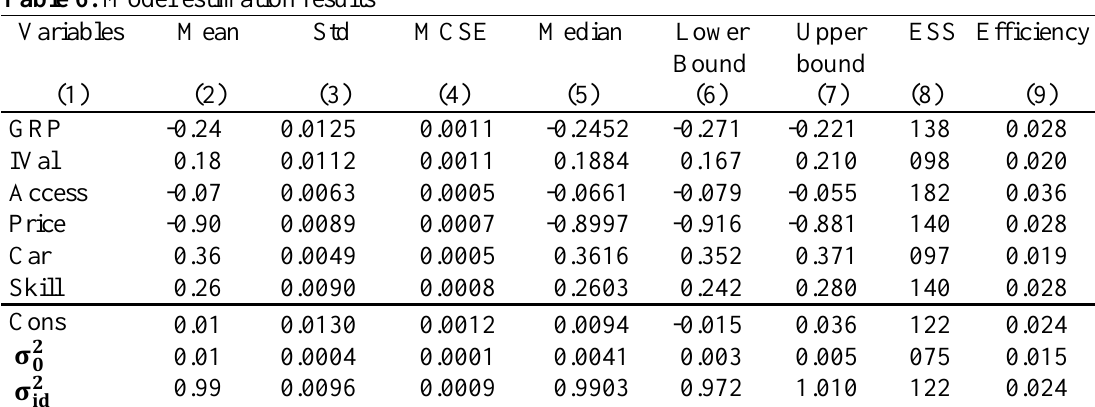
Table 6. Model estimation